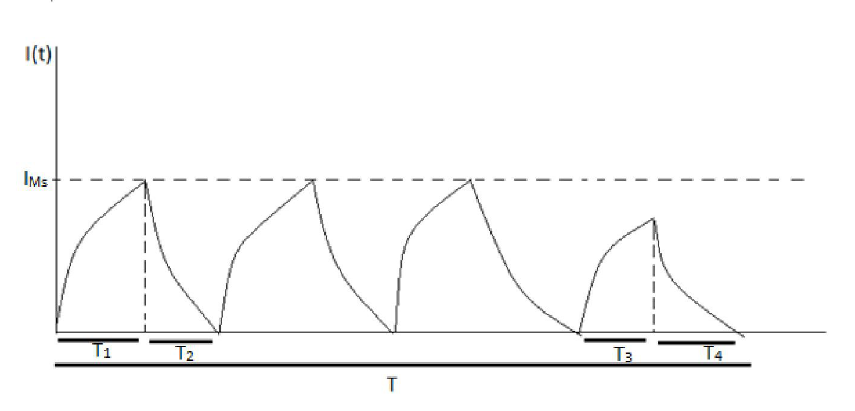
Fig. 2. Serviceable inventory level of 3 production setups and 1 rework